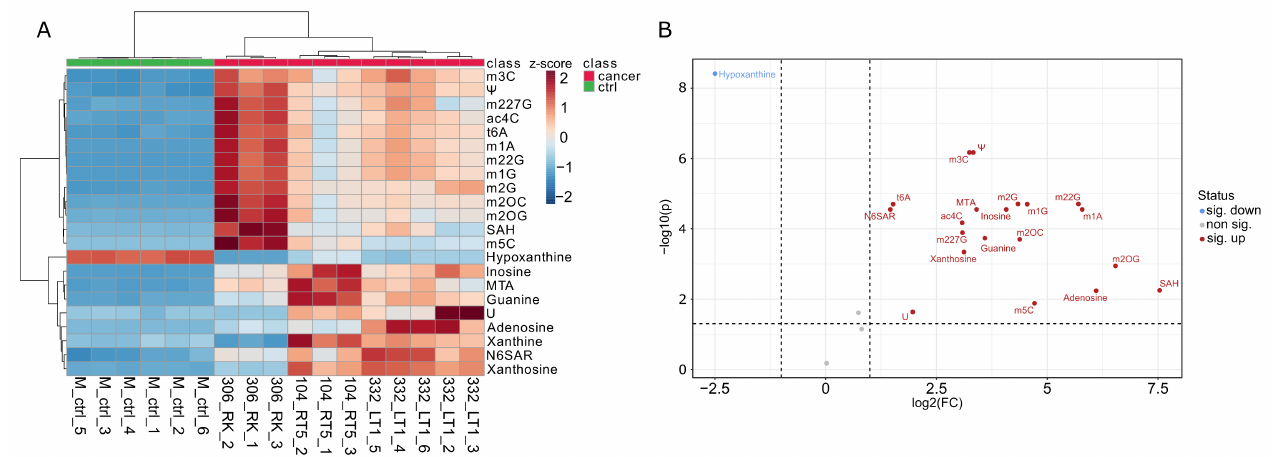
Figure 4. ( A ) Heat map analysis of the starvation approach. This analysis proves the previous findings. Modified residues were excreted into the medium. Hypoxanthine from the medium is consumed by the cells. The color scale on the right represents the relative concentrations of the respective nucleosides. ( B ) Volcano plot of the starvation approach. Significantly increased or decreased metabolites are displayed. Modified residues that were shown to be excreted in the rich medium are also increased in the starvation medium. The increase in the respective compound is represented by log 2 of the fold change, with the y-axis representing the p